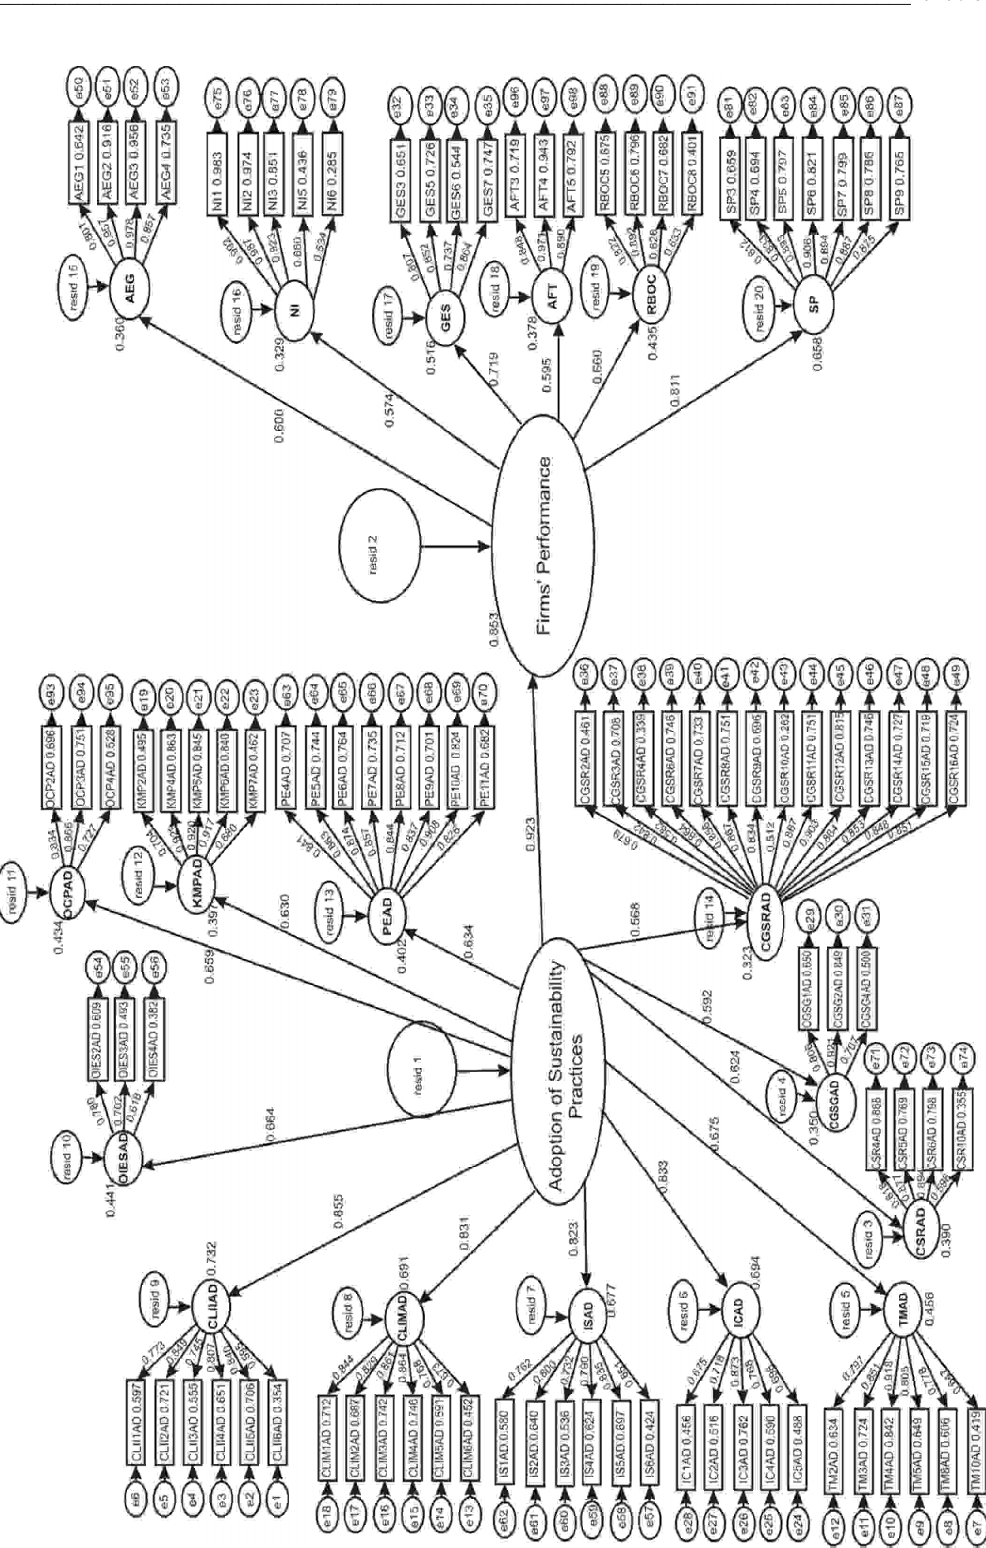
Fig. 4. Structural equation model predicting the performance of construction firms from the adoption of sustainability practices (developed by the